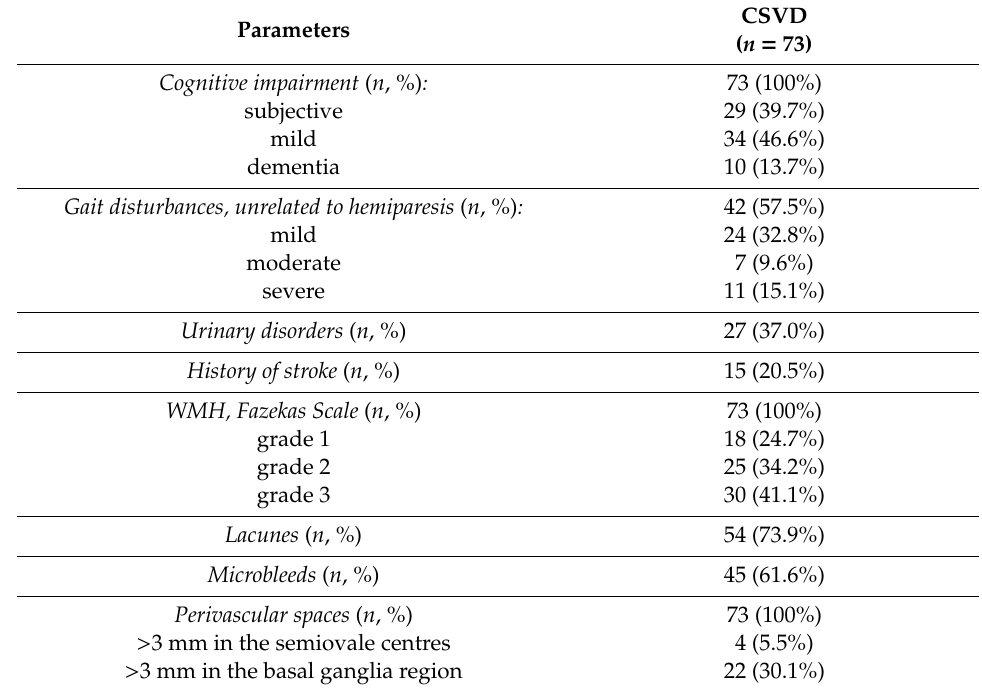
Table 2. Clinical symptoms and MRI signs of CSVD in patients with